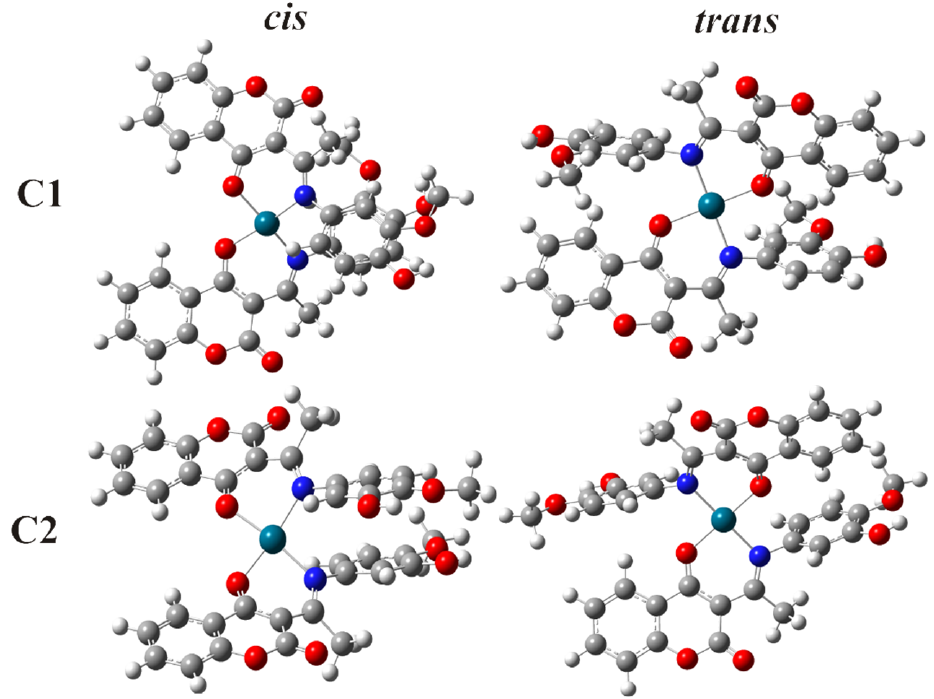
Figure 2. Optimized geometries of cis and trans isomers of C1 and C2. Theoretically, two isomers, cis and trans, can be obtained in the last step of the synthe- sis process presented in Scheme 1. When the energies of these isomers were compared, it was revealed that the trans isomers were more stable in both circumstances. The energy dif- ferences between the two isomers are 11.26 and 16.11 kJ/mol for the C1 and C2 complexes, respectively, while the Boltzmann distribution values are 99.95% and 99.98%. Based on these numbers, the trans isomer is clearly dominant in both cases. This is due to the steric interference and charges repulsion of aromatic rings. Additionally, the NMR and IR spectra of both isomers were simulated to confirm that the hypothesized theoretical structures of the studied compounds correspond to the structure of the synthesized compounds. Tables S1–S3 show the structural parameters for the most stable structures of all studied compounds. Tables S4 and S5 provide the experimental and computed values for chemical shifts. The correlation coefficient (R) and mean absolute error (MAE) were used to assess the validity of the linear correlation between the experimental and computed chemical shifts in the NMR spectra. The relatively significant correlation coefficients for 1 HNMR between 0.991 and 0.990, as well as the relatively small values of MAE, suggest that the computed geometries of examined compounds are in good correlation with the experimen- tally obtained structures [30–32]. When it comes to the cis isomer, correlation coefficients of 0.973 and 0.969 are a lot lower than for the trans isomer, which indicates that trans isomer is dominant, as predicted by Boltzmann distribution. As can be expected, simulated IR spectra for cis and trans isoforms are fairly similar, which can be seen in Figure 3. In addition, correlation coefficients were determined taking into account all the important peaks from the experimental data given in Section 3.1.2. More detailed information about the experimental and theoretical IR spectra is given in Table